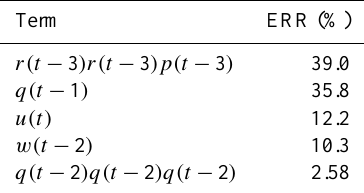
Table 1. ERR test results for the example